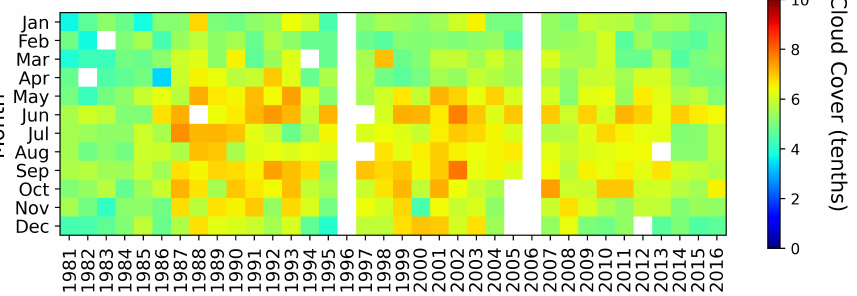
Figure 7. Monthly mean values of cloudiness for each year during the measured period from